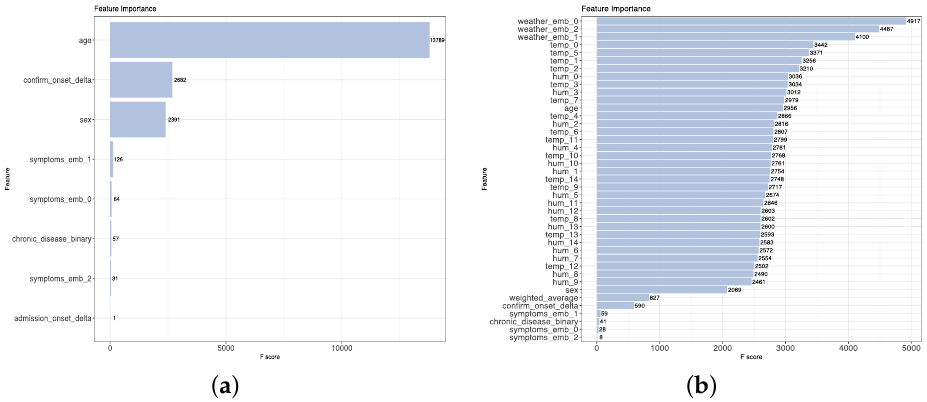
Figure 6. Feature scores on the enhanced structured dataset. ( a ) XGBoost processing of the initial structured dataset identified age as an important feature. ( b ) XGBoost processing of the enhanced structured dataset identified in the weather as an important feature.